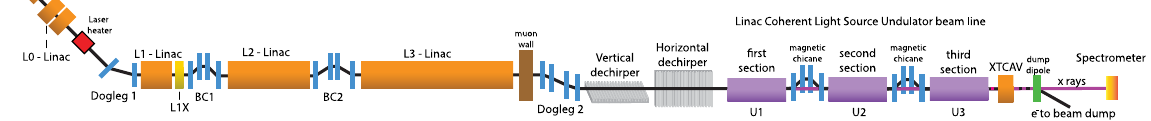
FIG. 1. The LCLS layout for fresh-slice three-stage XFEL pulse generation. Linac sections accelerate the electrons. The X-band transverse deflecting cavity (XTCAV) diagnoses the longitudinal phase space after the undulator beam line. L1X is the X-band linearizer cavity. BC1 and BC2 are the two bunch compressors. Dechirper and undulator sections are located downstream of the second